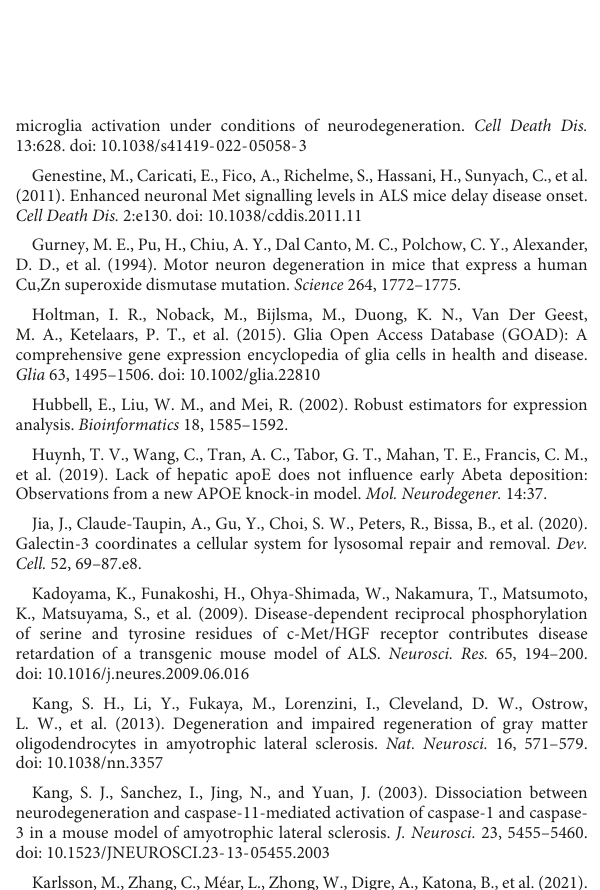
C, D, and E show gene expression fold changes in spinal cords of SOD1 G93A , SOD1 G85R , and SOD1 G37R mutant mice, respectively. Columns F to J show the integrated transcriptome. Columns K to Q show the SOD1 G93A cell-type transcriptome. Columns R, S, T, and U show gene expression fold changes in spinal cords of SOD1 G93A mutant mice at 70, 98, 112, and 126 days old, respectively. Columns V, W, and X are gene symbol, Entrez Gene ID, and gene title, respectively. Rows 3 to 56 are control and marker genes. Below row 57, entities are sorted by number and